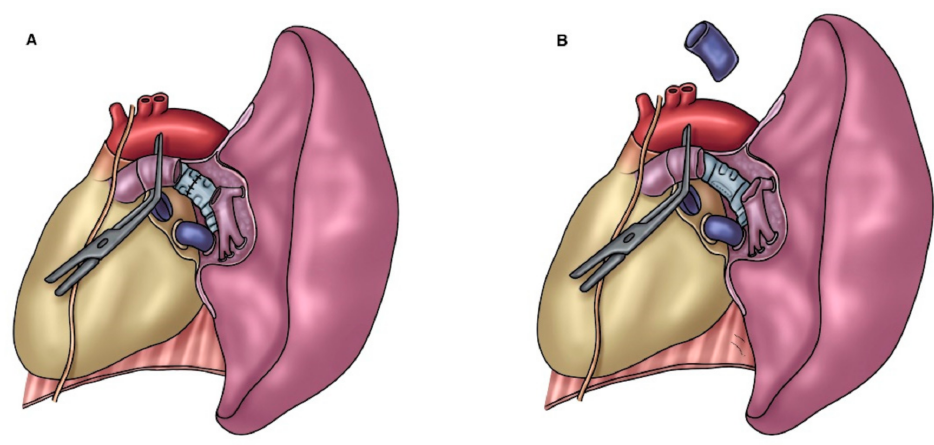
Figure 5. ( A ) Left PA defect ensued after a long-segment PA resection for a tumor of the left upper lobe; ( B ) Left PA reconstruction with an autologous pulmonary vein